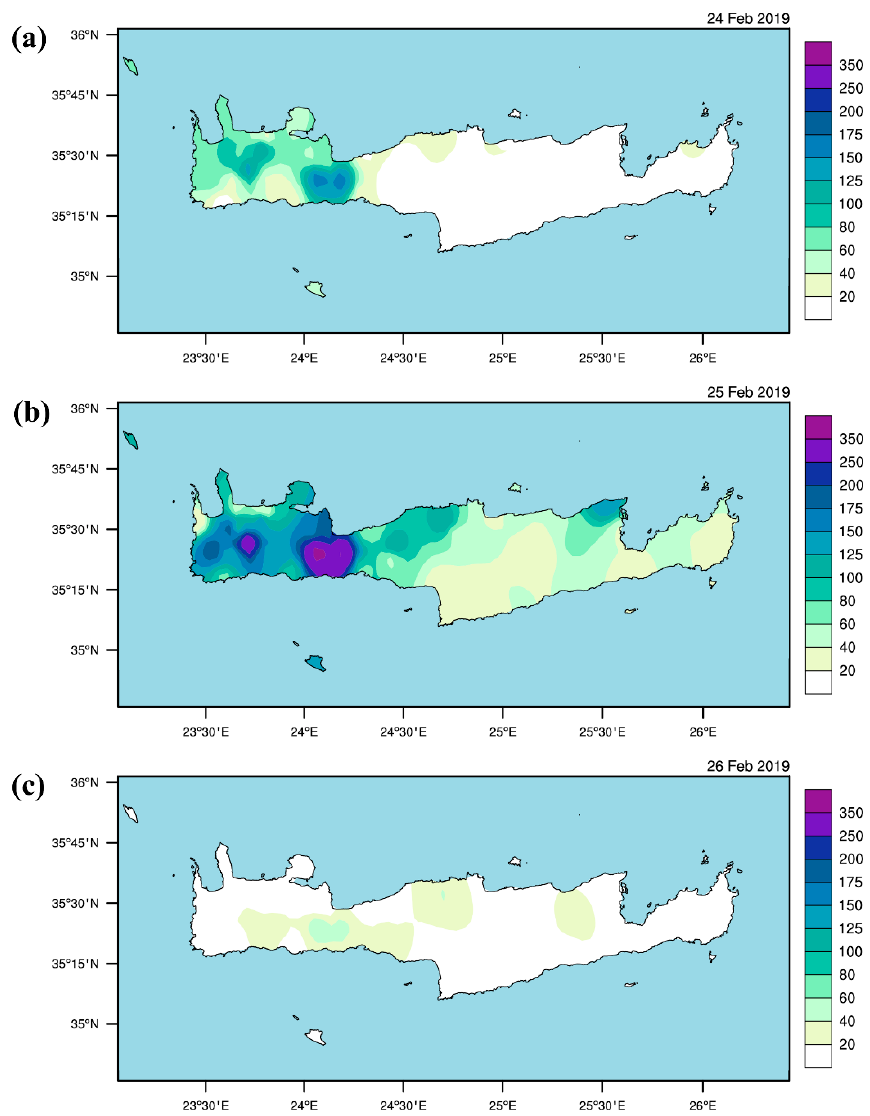
Figure A2. Total accumulated rainfall in Crete during the Oceanis storm for the periods spanning ( a ) from 0000 UTC 24 February to 0000 UTC 24 February 2019 (24 h), ( b ) from 0000 UTC 25 February to 0000 UTC 25 February 2019 (24 h), and ( c ) from 0000 UTC 26 February to 0000 UTC 26 February 2019 (24 h).